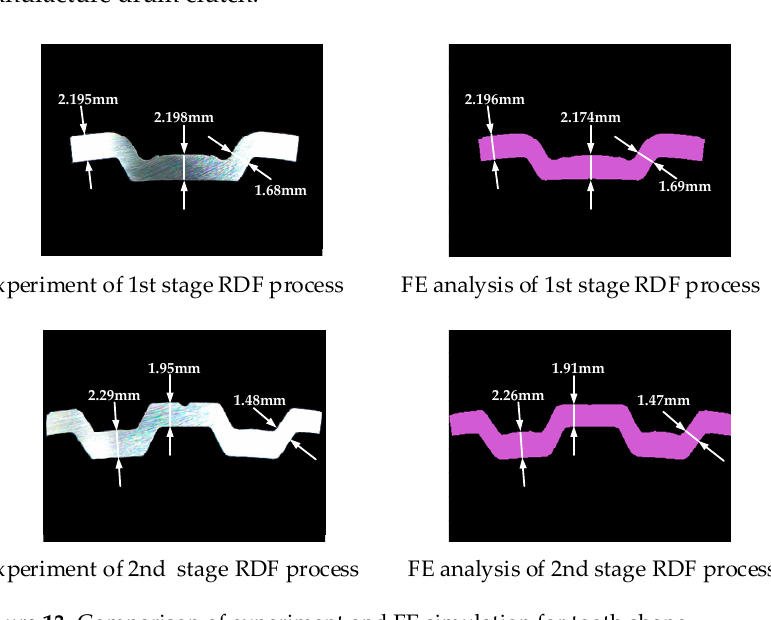
Figure 13. Comparison of experiment and FE simulation for tooth shape. Table 4. Comparison of the experiment and FE simulation for dimensional accuracy.